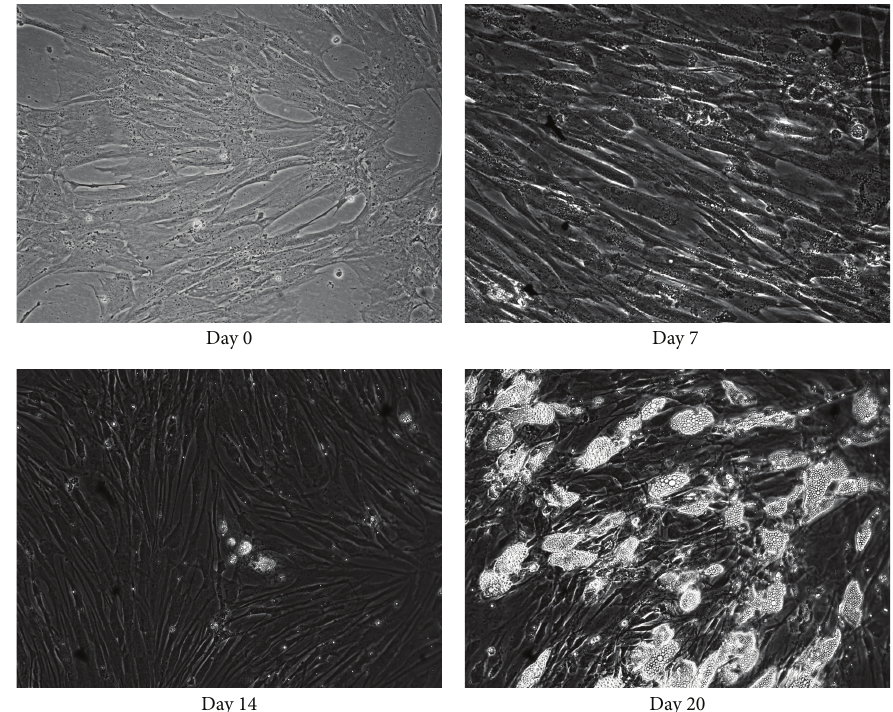
Figure 1: The differentiation process of SGBS preadipocytes to mature adipocytes at days 0, 7, 14, and